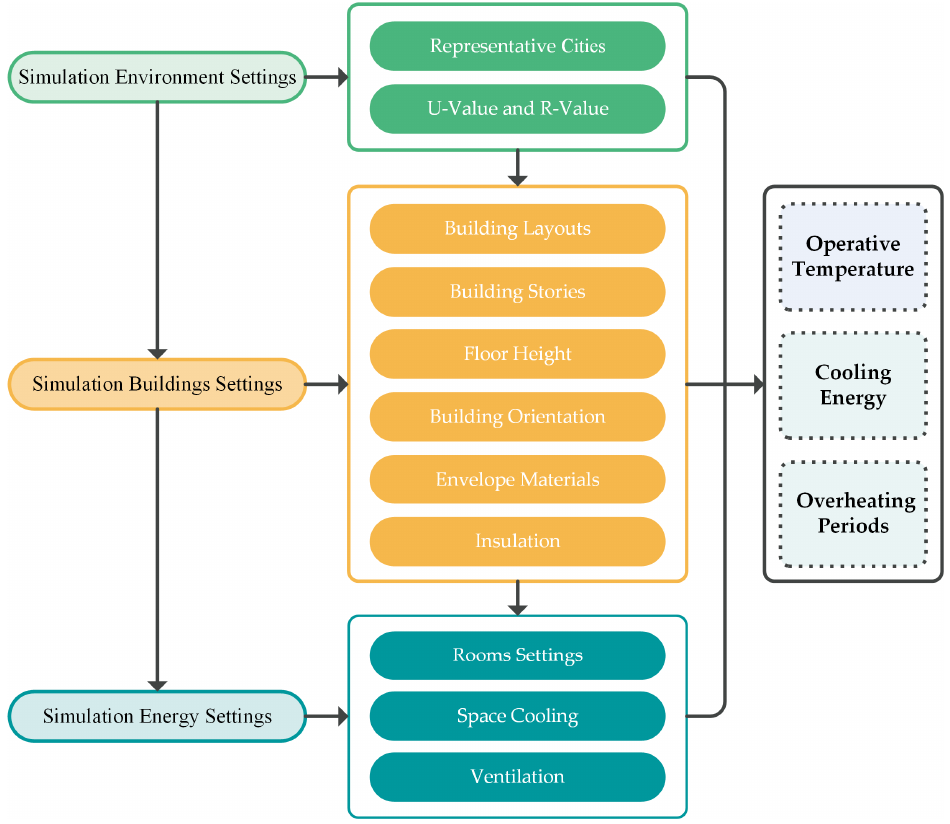
Figure 3. Flowchart of the building simulation. (Data source: drawn by the authors).